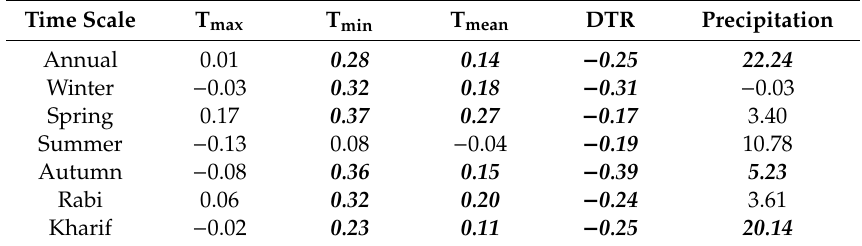
Table3. AnnualandseasonalMKtemperaturestrend( ◦ C / decade)indicesandprecipitation(mm / decade) in Punjab Province during 1967–2017 using Mann–Kendall and Sen’s